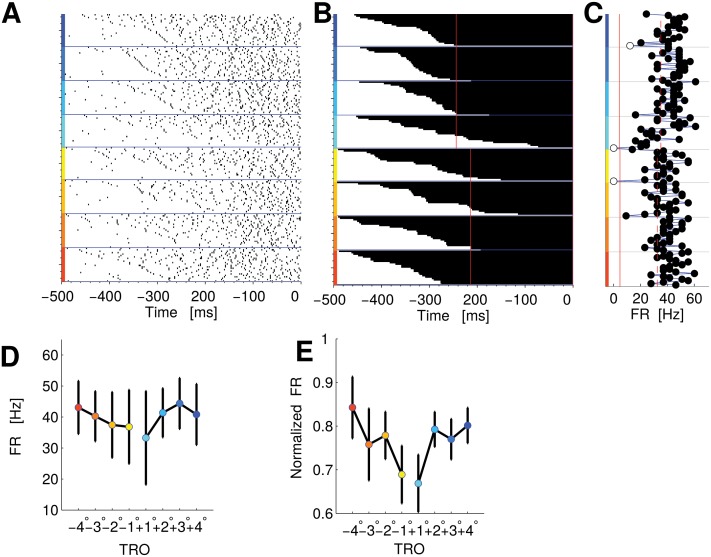
PMv single neuron and population encoding difficulty in the FRs with a rate code.Panel A: Raster plot as in Fig 5A. Panel B: Time course of state switchings, according to HMM for the same neuron of panel A (as in Fig 5B). Panel C: Average FRs of single trials from when the 90% of trials changed state until the end of the trial (as in Fig 5C). Panel D: Average FR for this same neuron versus TRO. Panel E: Normalized average FR for the whole populations of neurons encoding difficulty in the FRs with a rate code. The color code for the TRO is the same as Fig 1. Error bars of panels D and E represent SEM.